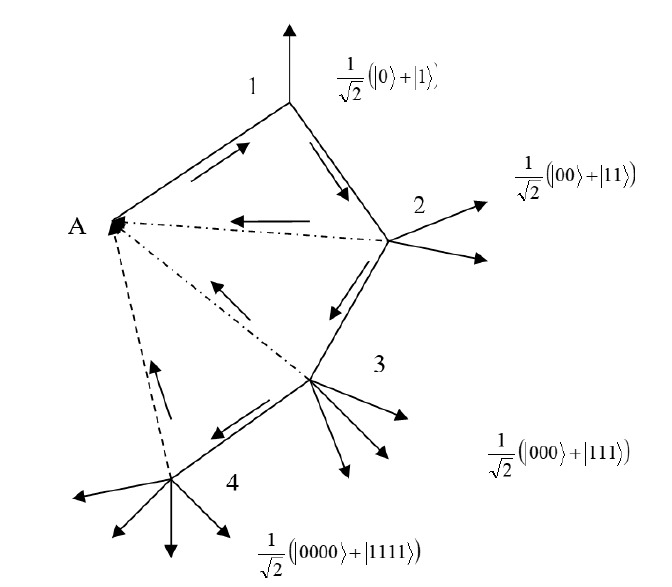
Figure 1. The Hidden Quantum Network (HQN).